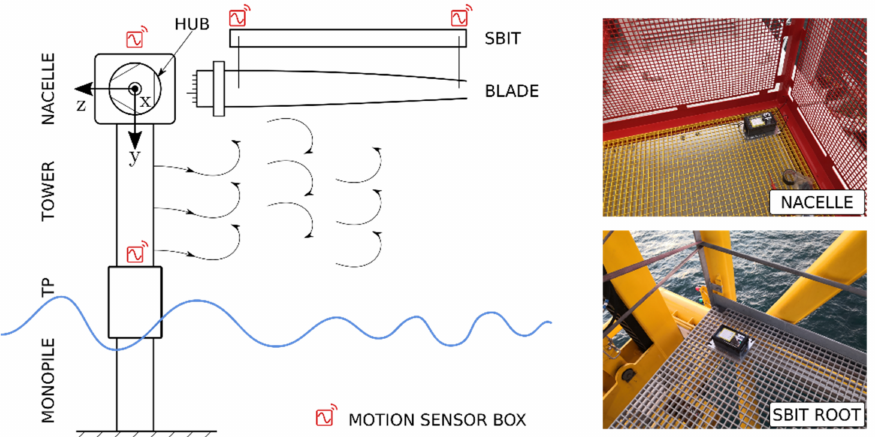
Figure 3. Placement of motion sensor boxes on different components during the installation of Trianel Windpark Borkum II. The blade lifting yoke is abbreviated as SBIT (Single Blade Installation Tool). The two images on the right show the sensor boxes placed on the helicopter hoisting platform atop the nacelle (top image), the SBIT, blade root side (bottom image). Modified after Sander et al.